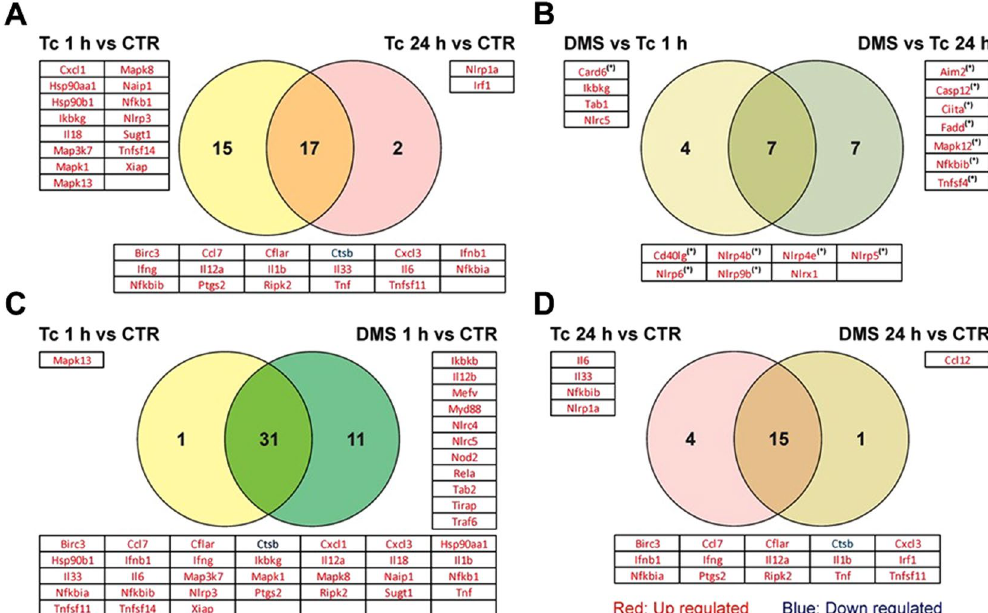
Figure 7. Venn diagrams representing differentially expressed genes (DEG) through T. cruzi infection with or without DMS treatment. ( A ) Comparison between DEG after 25 h (Tc 1 h condition) or 48 h (Tc 24 h condition) after T. cruzi infection with respect to uninfected macrophages (CTR condition). ( B ) Analysis of common DEG by DMS treatment for 1 h (DMS 1 h) and 24 h (DMS 24 h) when compared to infected macrophages. ( C ) Comparison between DEG by T. cruzi infection with or without 1 h DMS treatment with respect to uninfected macrophages. ( D ) Comparison between DEG during 48 h infection with or without 24 h DMS treatment with respect to uninfected macrophages. ( * ) indicates genes with |FC| ≥ 2 but p-values > 0.05.